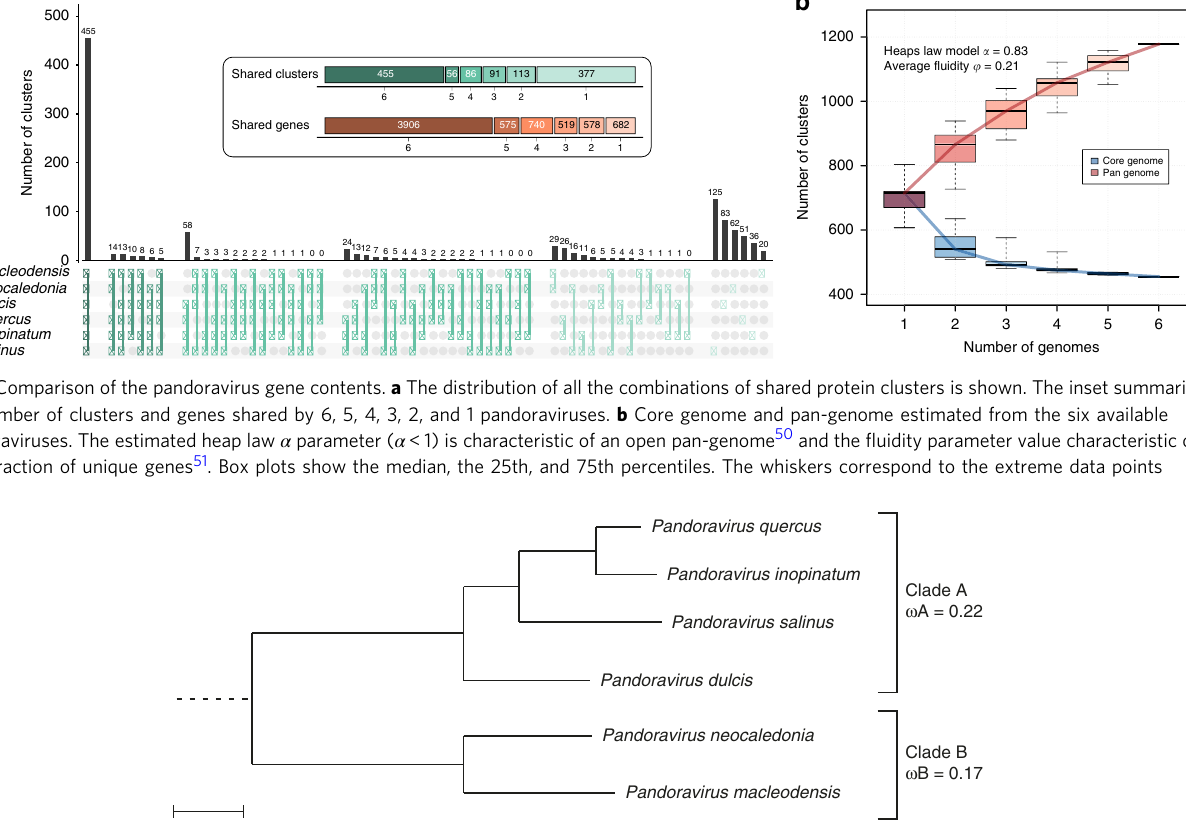
Fig. 3 Phylogenetic structure of the proposed Pandoraviridae family. Bootstrap values estimated from resampling are all equal to 1 and so were not reported. Synonymous to non-synonymous substitution rates ratios ( ω ) were calculated for the two separate clades and are signi fi cantly different (scale bar is 0.07